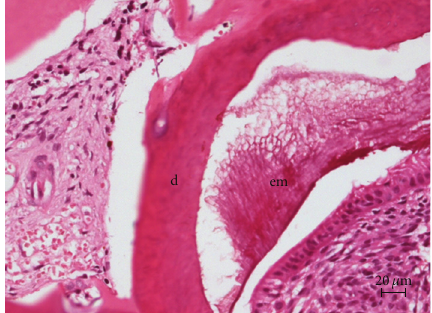
Figure 3: Cone-beam tomography (panoramic reconstruction) showing a well-circumscribed calcified mass in intimate contact with the alveolar inferior nerve.